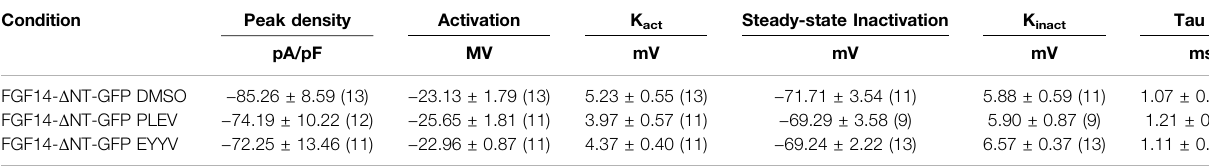
Data are mean ± SEM; ns (cid:2) nonsigni fi cant.